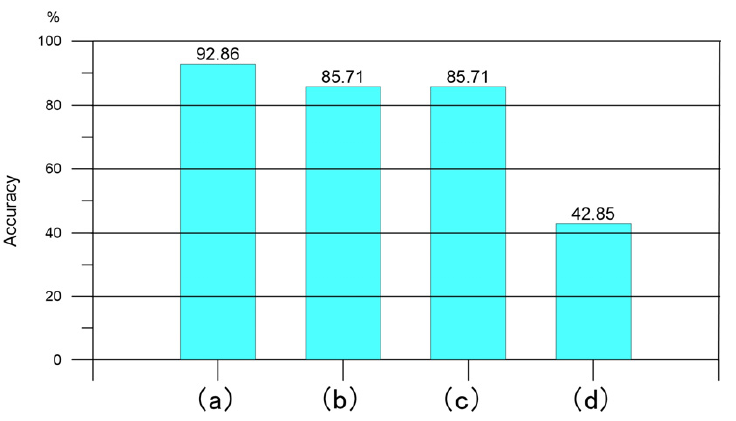
Figure 16. The accuracy comparison between the proposed method and the already studied methods: ( a ) the proposed method; ( b ) cosine similarity; ( c ) Jaccard coefficient; ( d ) TransE.